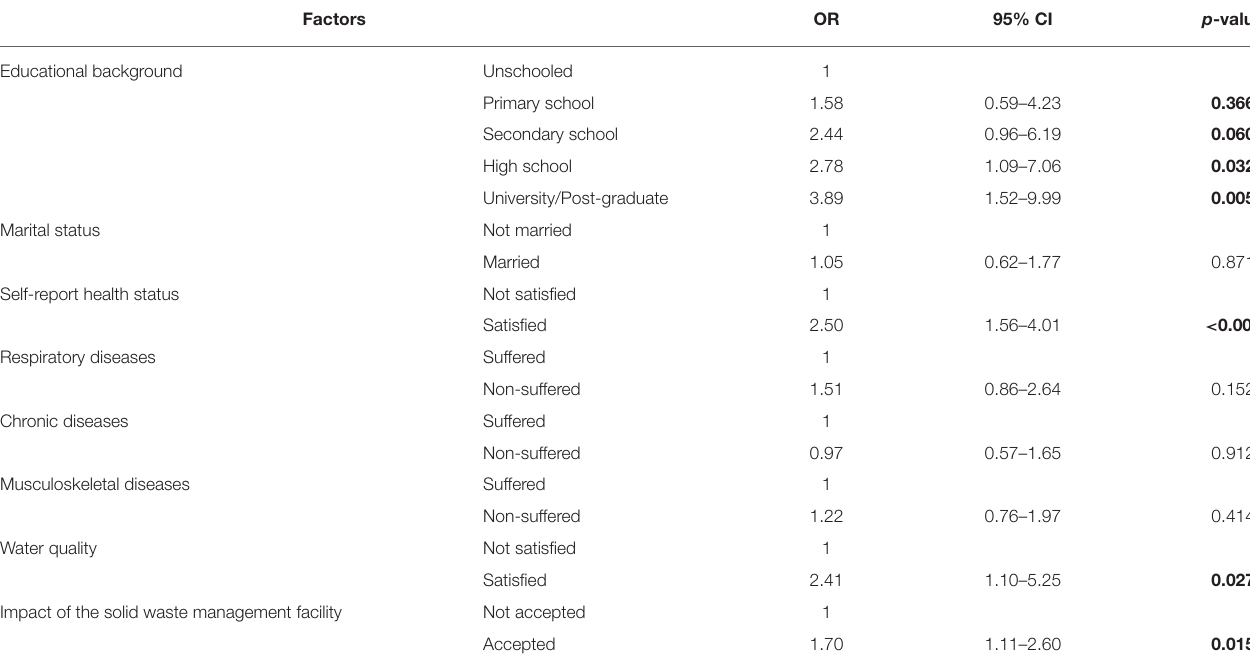
TABLE 4 | Factors affecting the quality of life of the subjects ( n = 801) as the result of multivariate logistic regression analysis. Factors